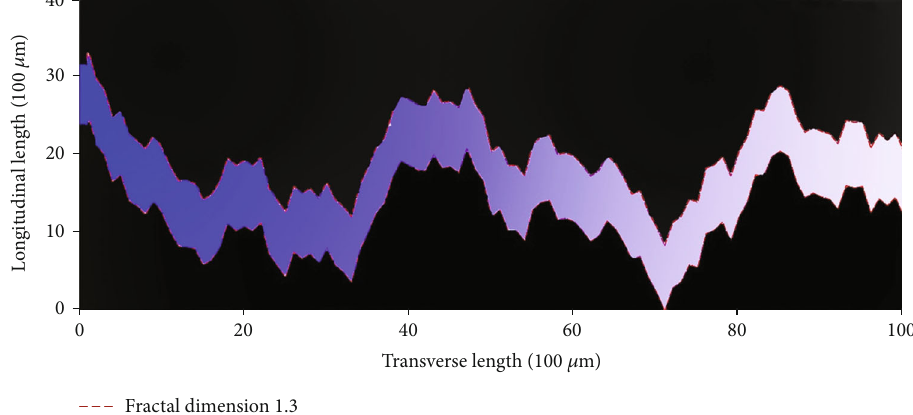
Figure 3: A fracture model with a fractal dimension of 1.3.